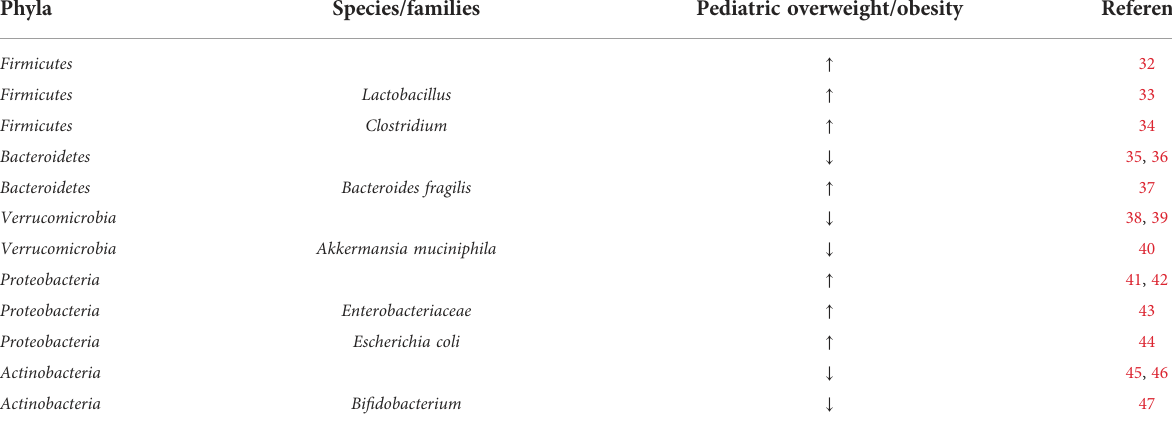
TABLE 1 Relationships between gut microbiota and pediatric overweight/obesity.